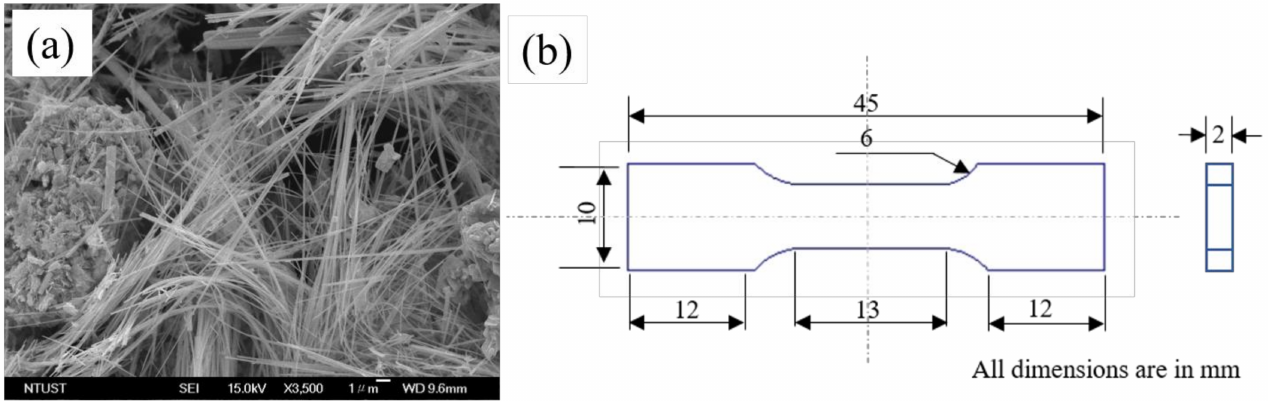
Figure 1. ( a ) Microstructure of WS 2 and ( b ) tensile